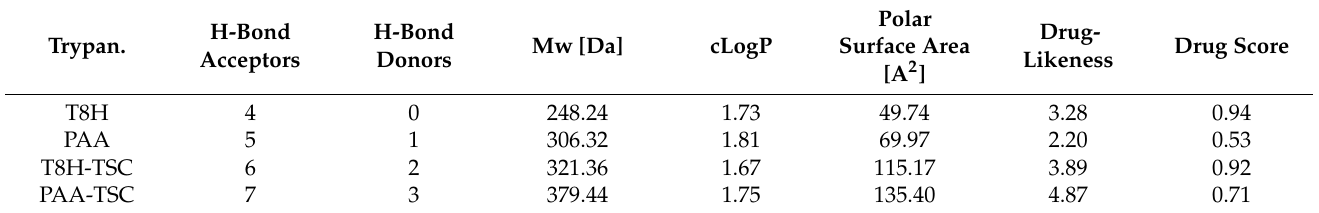
Table 5. Lipinski’s rule parameters for tryptanthrin derivatives.